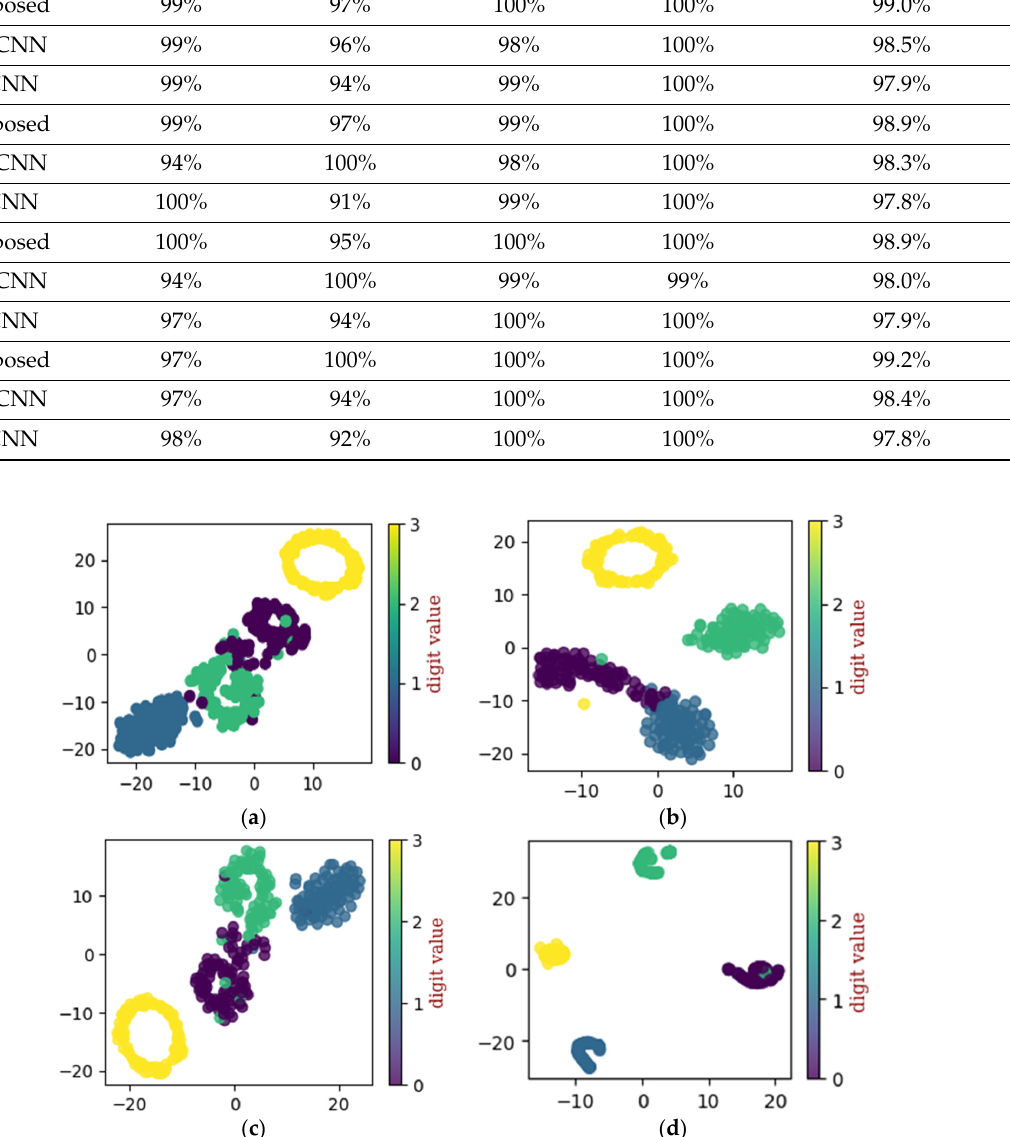
Figure 13. The confusion matrix for this classification.